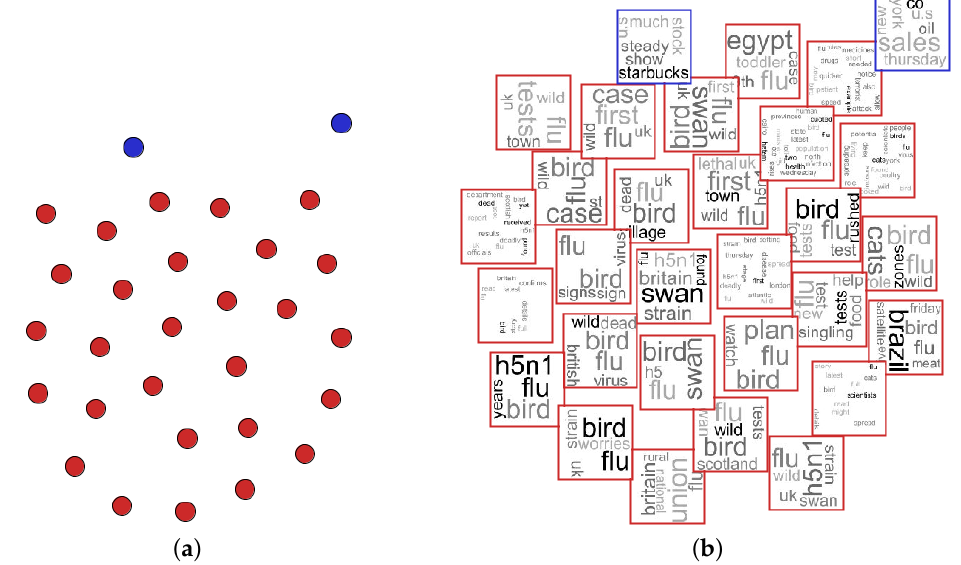
Figure 7. Analysis of the NEWS-13 dataset: ( a ) zoom in of Selection B from Figure 6 and ( b ) the tag cloud mapping from ( a ).